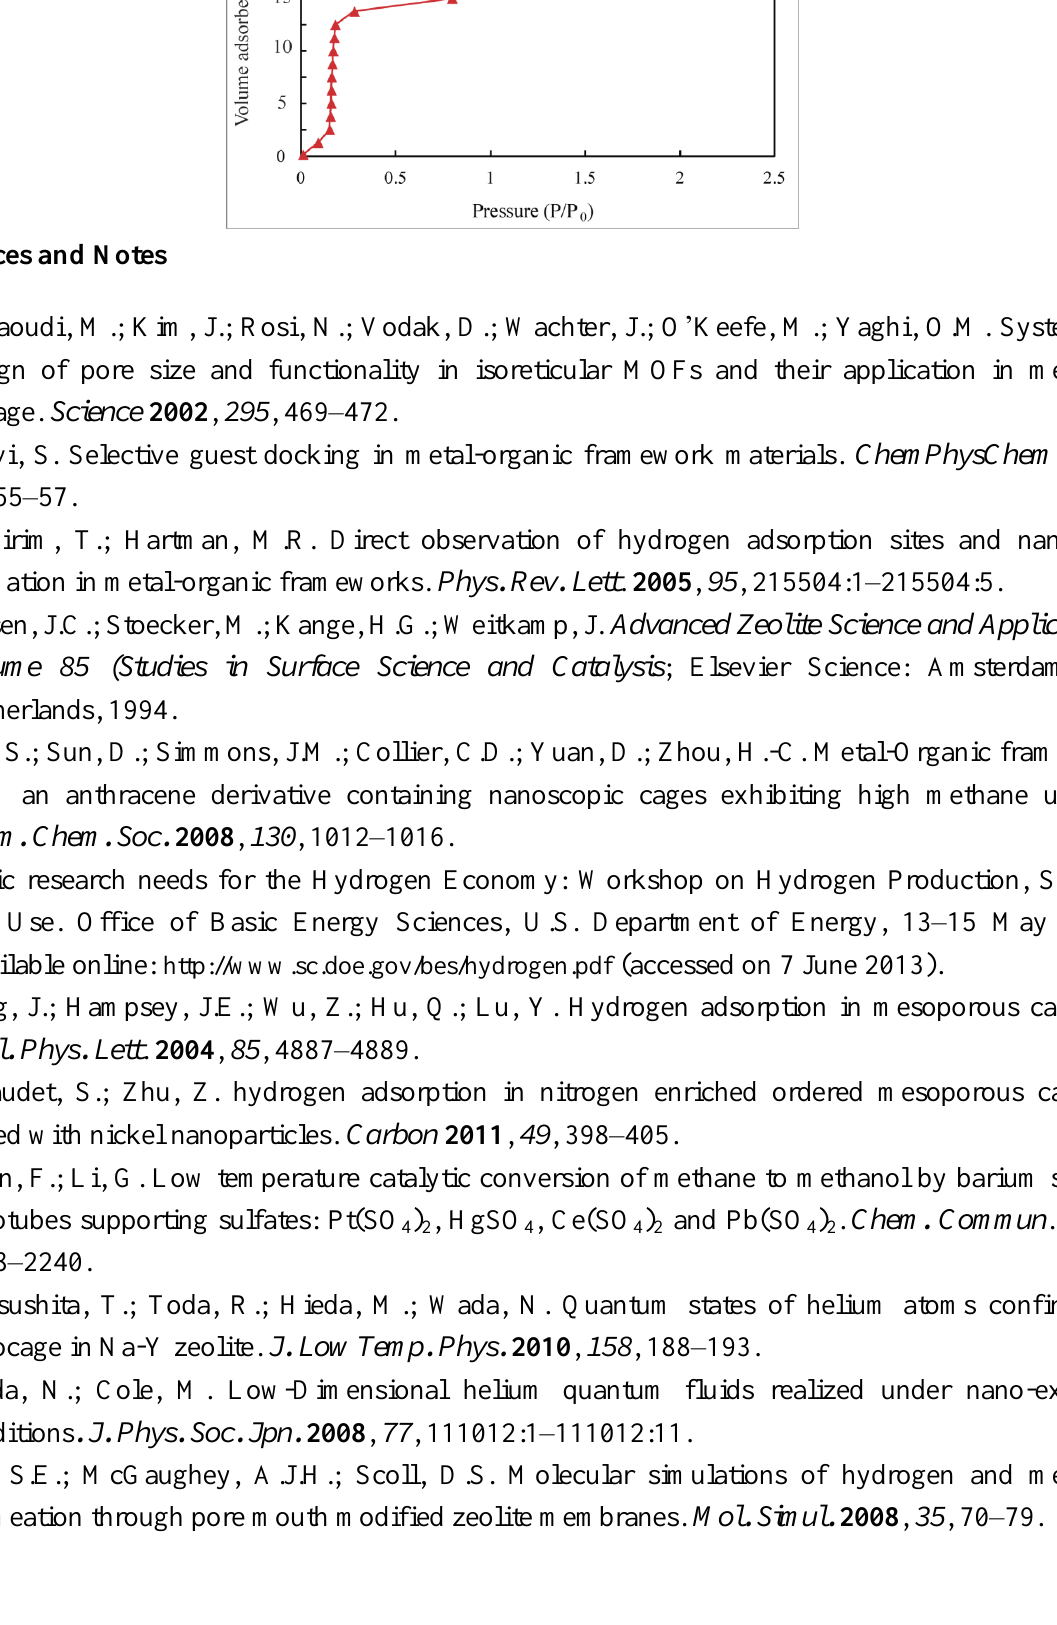
Figure B1. Adsorption isotherm for methane on zeolite-13X at 77 K. P